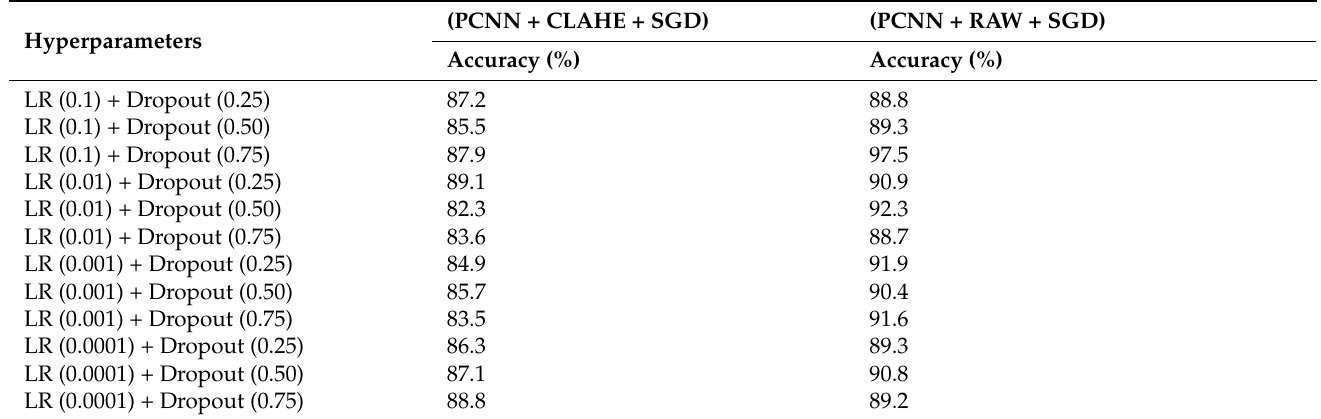
Table 9. Performance evaluation of the proposed PCNN based on different hyperparameter tuning on our dataset with SGD